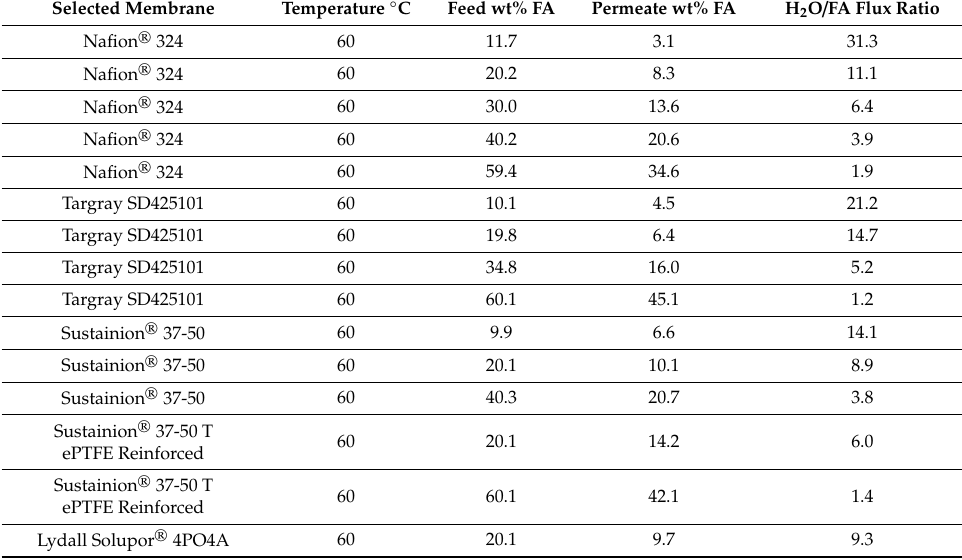
Figure 3. Comparison plot of the permeation rates of FA and H 2 O for the tested membranes in a range of 10 to 60 wt% FA solutions operating at a permeation system temperature of 60 °C. Table 5. Summary table of the membranes and calculated H 2 O / FA permeation mass flux ratios from Table 4. Selected